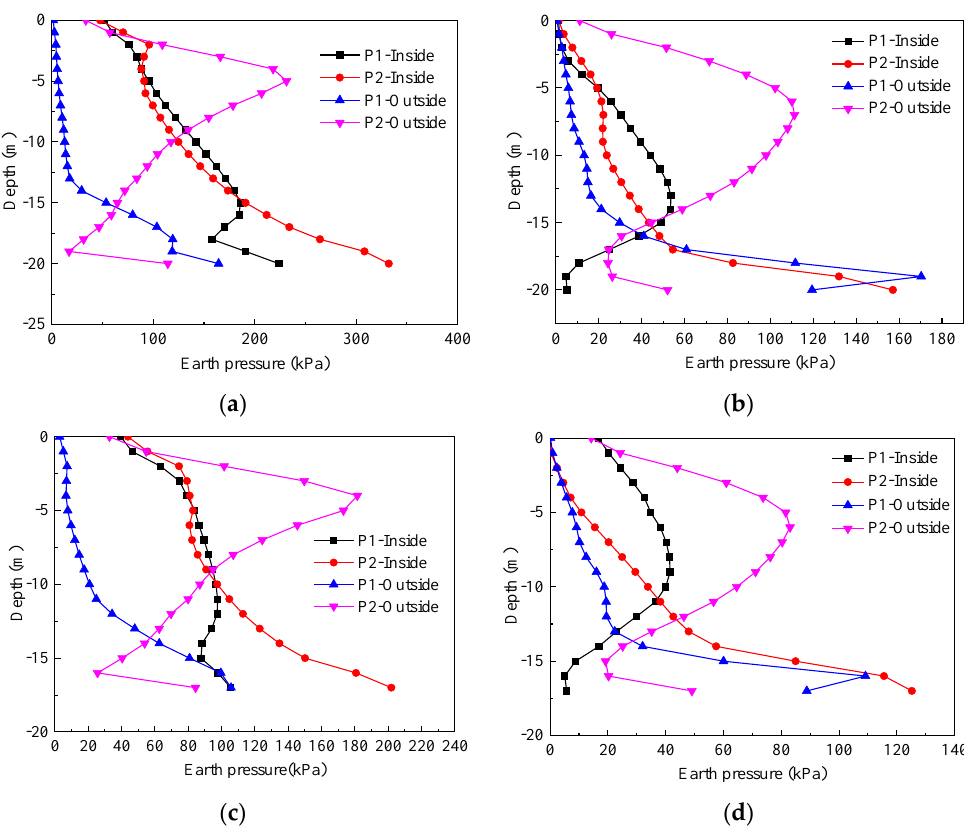
Figure 13. Distribution of earth pressure inside and outside TSPJF and TBJF along the skirt height under ultimate horizontal load. ( a ) 1# bucket of the TSPJF, ( b ) 2# bucket of the TSPJF, ( c ) 1# bucket of the TBJF, ( d ) 2# bucket of the TBJF.